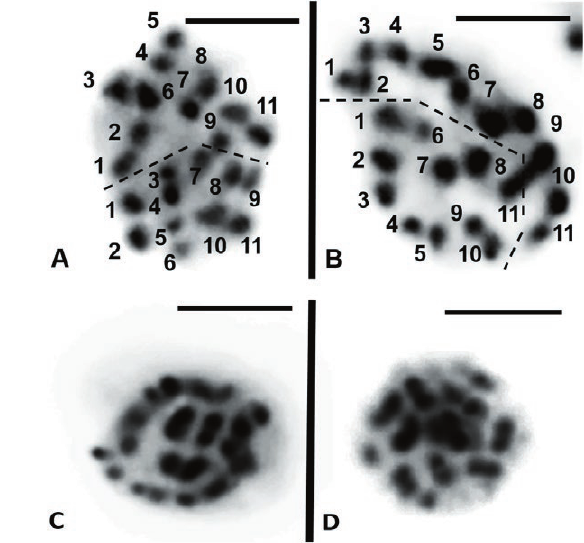
Figure 2. Bivalent chromosomes of P. friedrichsthalianum in mei- otic metaphase, stained with DAPI, scale bar 10um. (a, b and c) Samples from the populations of Cervantes, Tacacorí and Escazú respectively, showing 11 bivalent chromosomes. (d) Image showing chromosomes in trivalent, bivalent and univalent